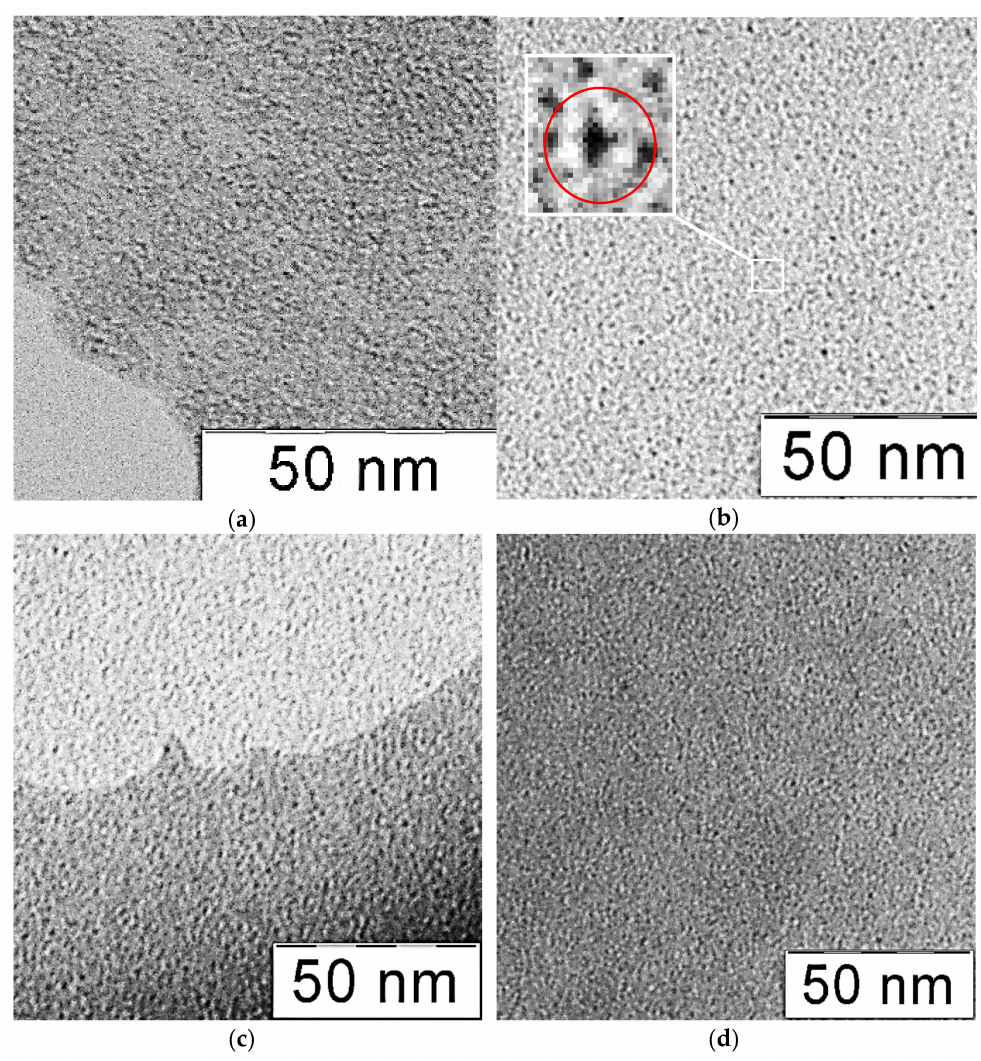
Figure 3. Transmission electron microscopy (TEM) images of molybdenum–tungsten blue nanopar- ticles, synthesized with various molar ratios: (Mo)/(W) = 95/5 ( a ), (Mo)/(W) = 90/10 ( b ), (Mo)/(W) = 80/20 ( c ), and (Mo)/(W) = 50/50 ( d